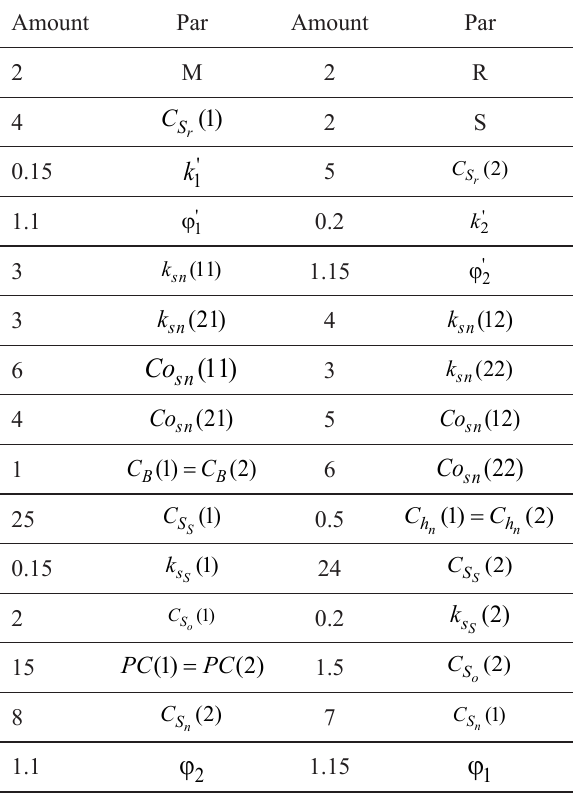
Table 6. Initial data for the numerical example